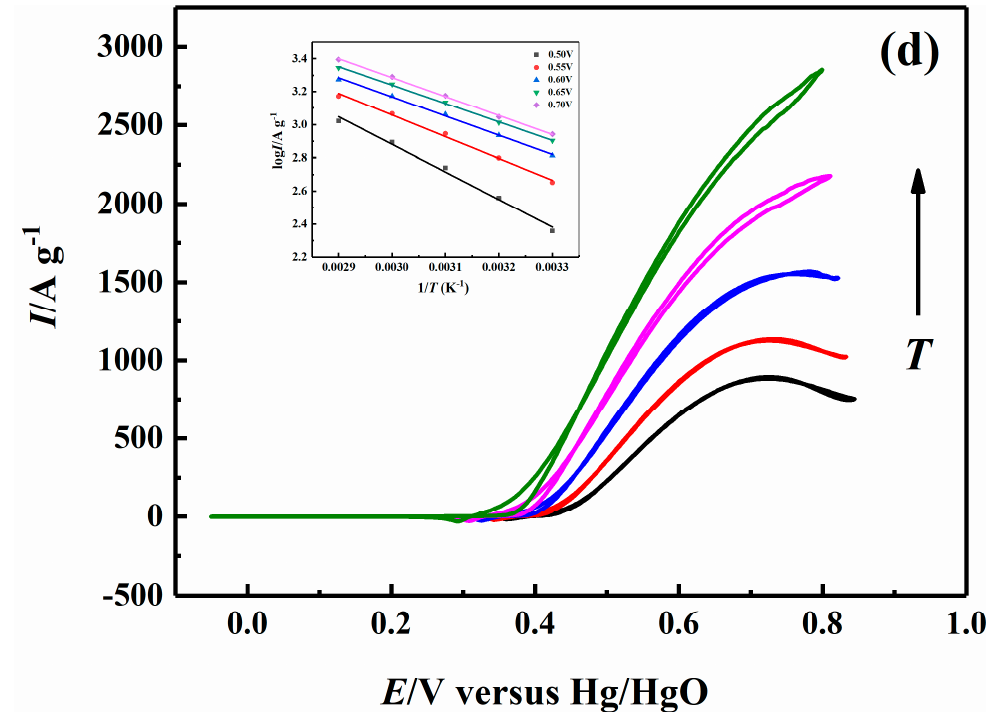
Figure 6. Cyclic voltammograms of the methanol oxidation on Ni-B ( a ), Ni-B-Co 0.02 ( b ), Ni-B-Co 0.05 ( c ), and Ni-B-Co 0.1 ( d ) nanoparticles in a range from 0.0 to 0.85 V at different temperatures in 1.0 M NaOH + 1.0 M CH 3 OH solution. Inset: Arrhenius plots of the methanol oxidation on the Ni-B and Ni-B-Co nanoparticles at different potentials. Table 4. The E a (kJ mol − 1 ) of methanol oxidation on the Ni-B and Ni-B-Co nanoparticles at di ff erent